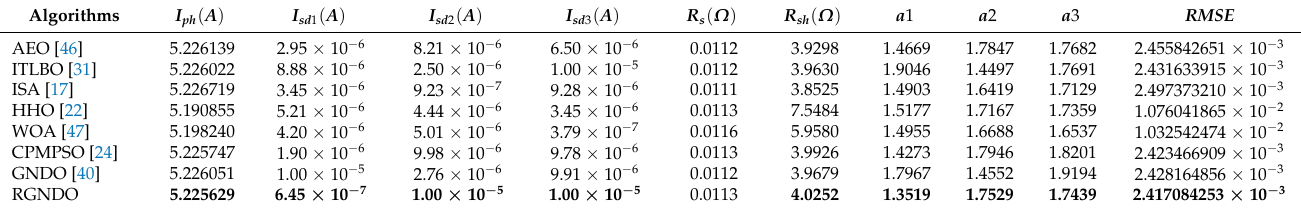
Table 9. Comparison of the best RMSE and its extracted parameter per cell on Ultra